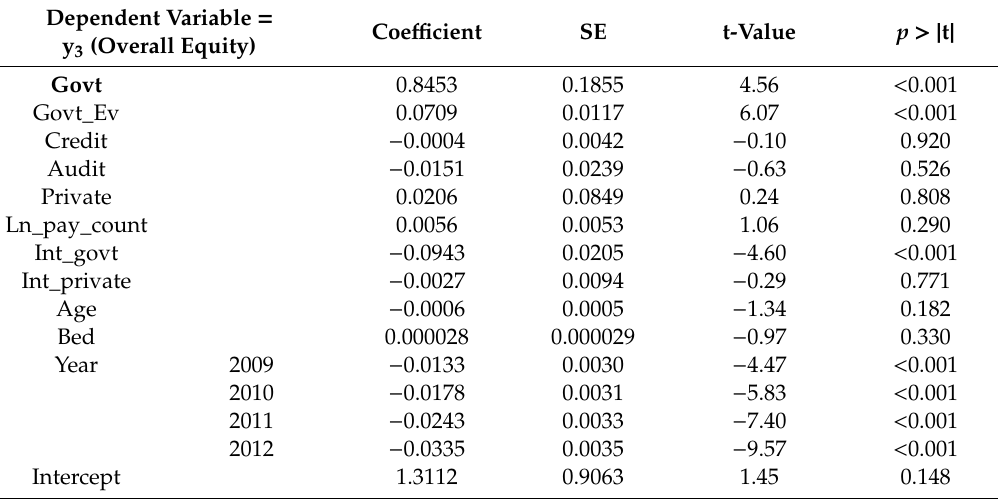
Table 9. Fixed e ff ects regression of publicness on overall